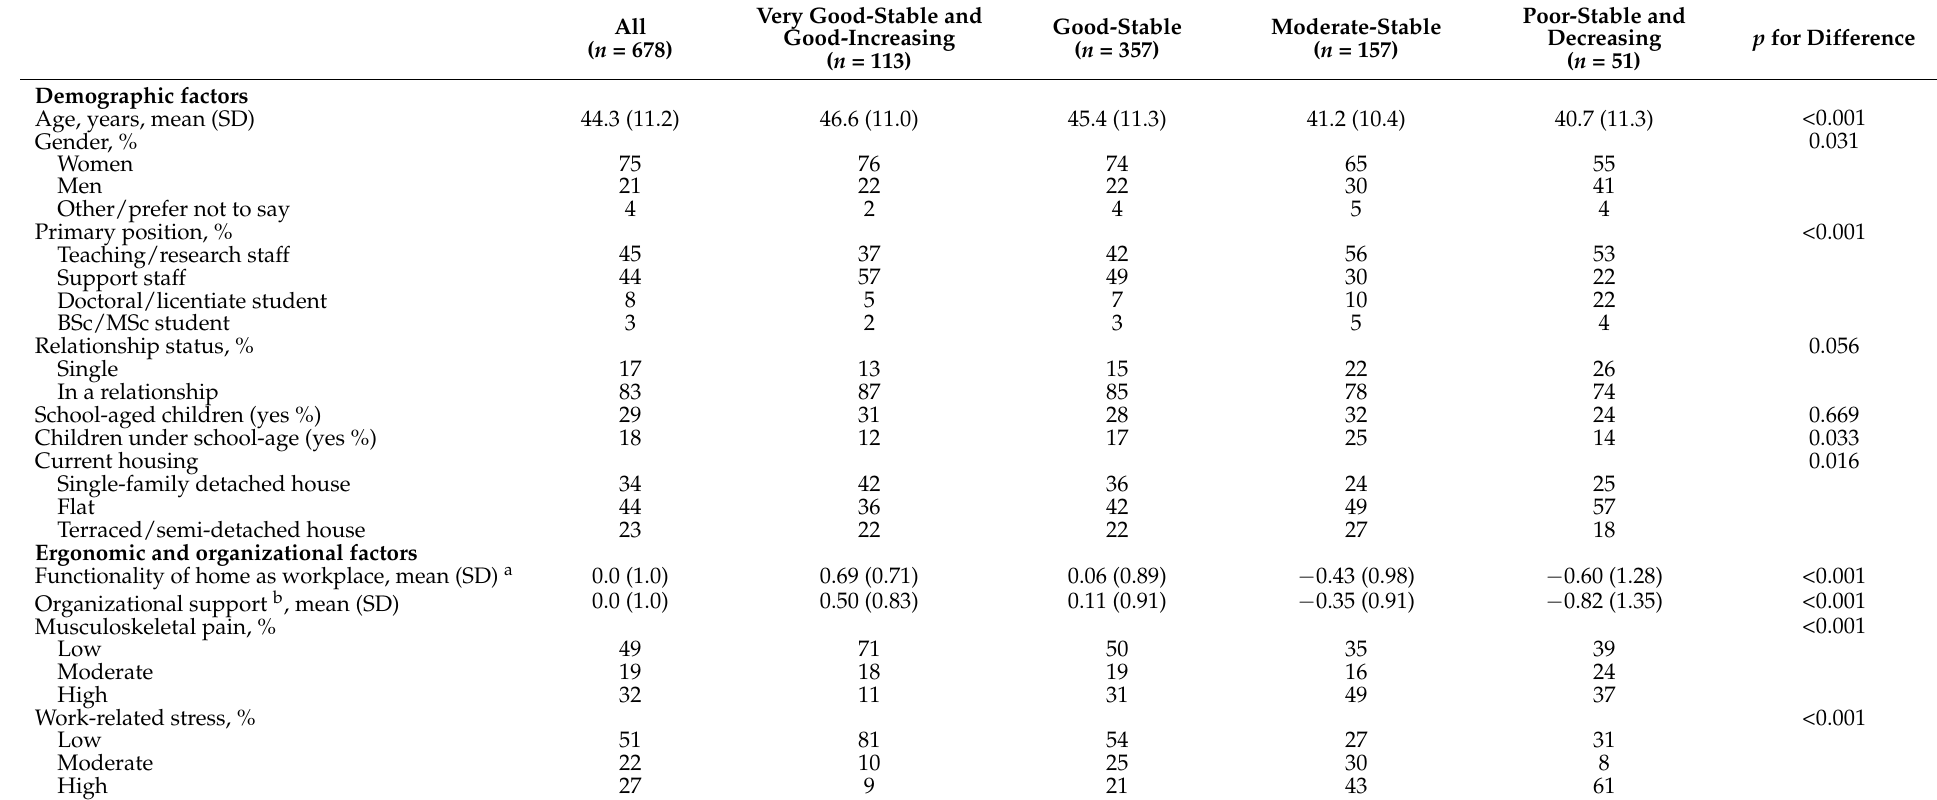
Table 1. Baseline characteristic of the study population and each of the derived work ability profiles among university staff ( n = 678).